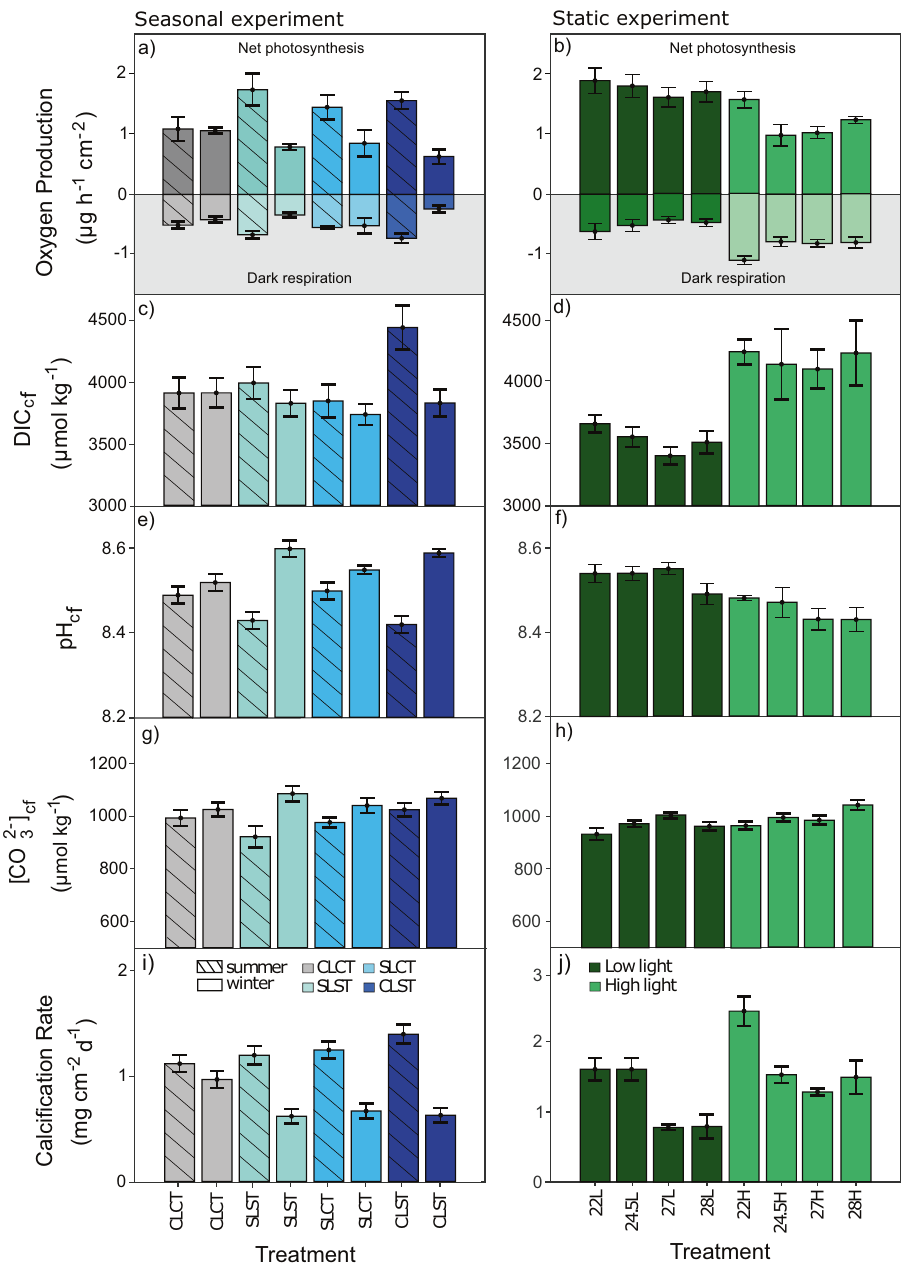
Fig. 3 Coral metabolic rates, calcifying fl uid carbonate chemistry and calci fi cation rates. Changes in ( a , b ) net photosynthesis and dark respiration rates, ( c , d ) calcifying fl uid dissolved inorganic carbon (DIC cf ), ( e , f ) calcifying fl uid pH (pH cf ), ( g , h ) calcifying fl uid carbonate ion concentration ([CO 3 2- ] cf ), and ( i , j ) calci fi cation rates for the coral Acropora nasuta . Values shown are mean ± SE. On the left is experiment 1 during summer (stripes) and winter (no stripes) for the three treatments with seasonally variable temperature and/or light, and the control treatment (grey). On the right is experiment 2 showing each of the eight temperature and light treatments at the end of the experiment. Treatment conditions for experiment 1 are the following: constant light and constant temperature (CLCT), seasonal light and constant temperature (SLCT), constant light and seasonal temperature (CLST), and seasonal light and seasonal temperature; (SLST). Treatment conditions for experiment 2 consist of high (28H, 27H, 24.5H, and 22H) and low (28 L, 27 L, 24.5 L, 22 L) light diurnal PAR cycles at each of the four temperatures (28 °C, 27 °C, 24.5 °C, and 22